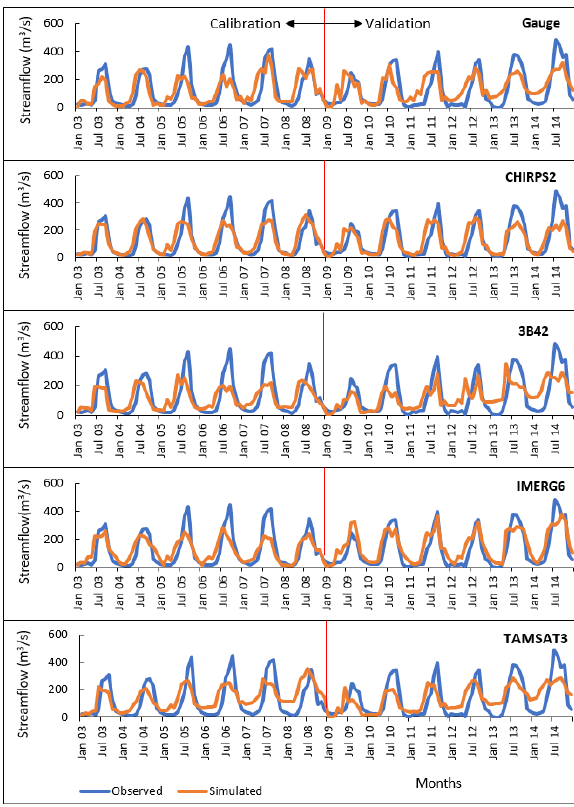
Figure 8. Graphical calibration and validation of streamflow at monthly scales.